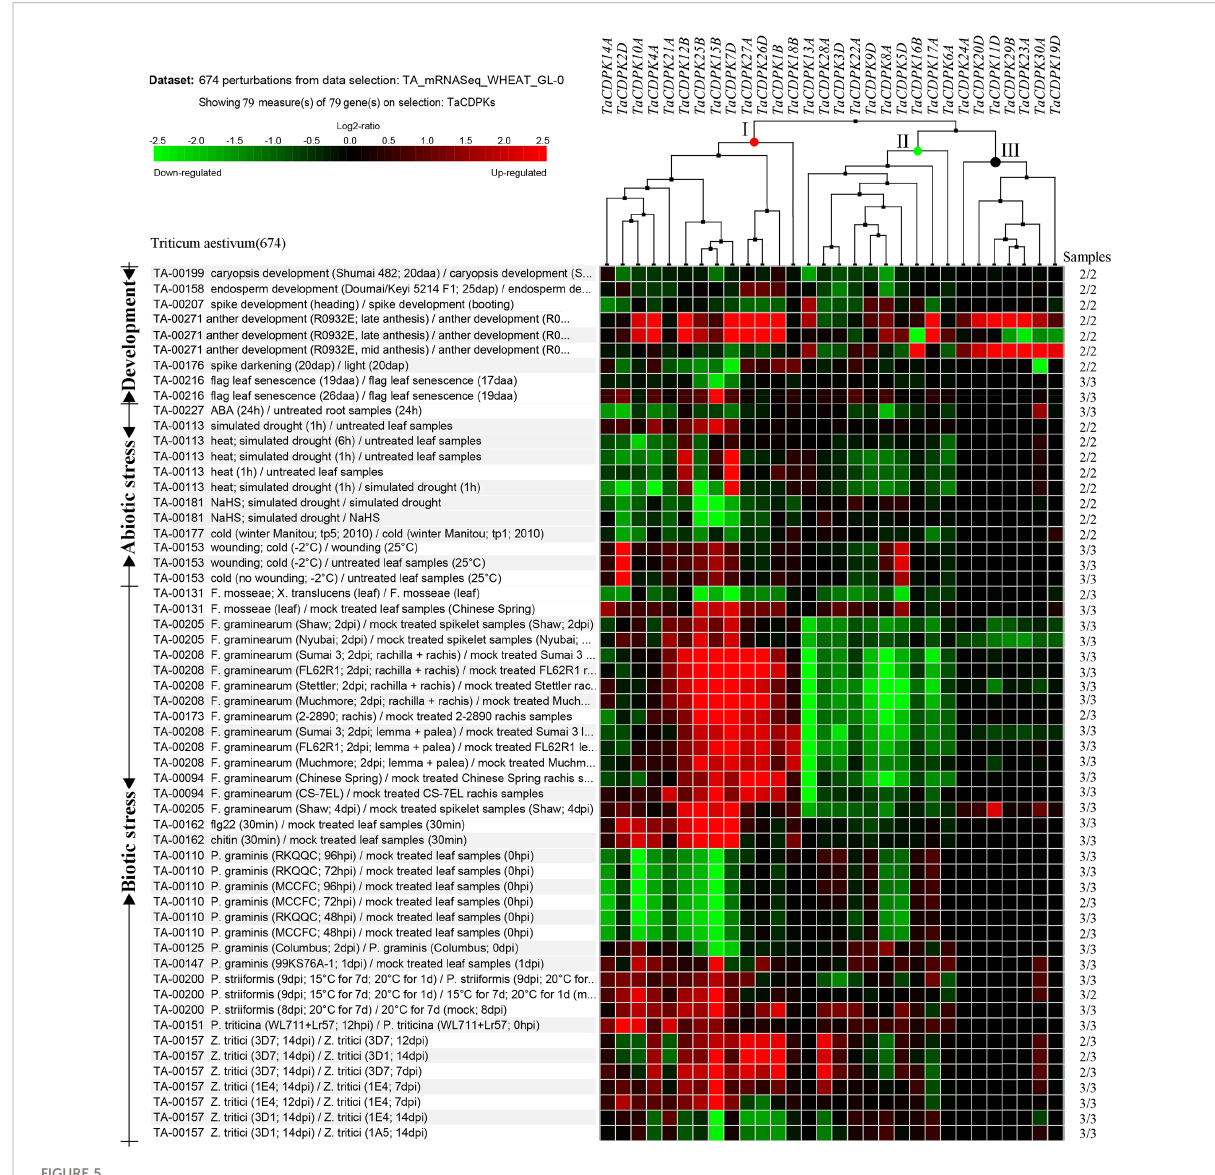
FIGURE 5 Inducible expression pro fi les of TaCDPKs in wheat. Inducible expression pro fi les of TaCDPKs under a wide of environmental stresses and hormone treatments were selected from the Ta_mRNASeq_WHEAT_GL-0 database in Genevestigator v3. For clear and beautiful presentation of the pro fi les, each of the 30 members shown in the Figure 5 contains its homologues (which had been deleted), so there are 79 members in